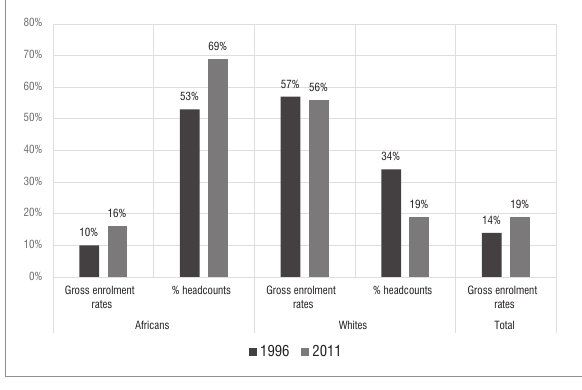
Figure 1: Gross enrolment rates in higher education for black African and white students, in 1996 and